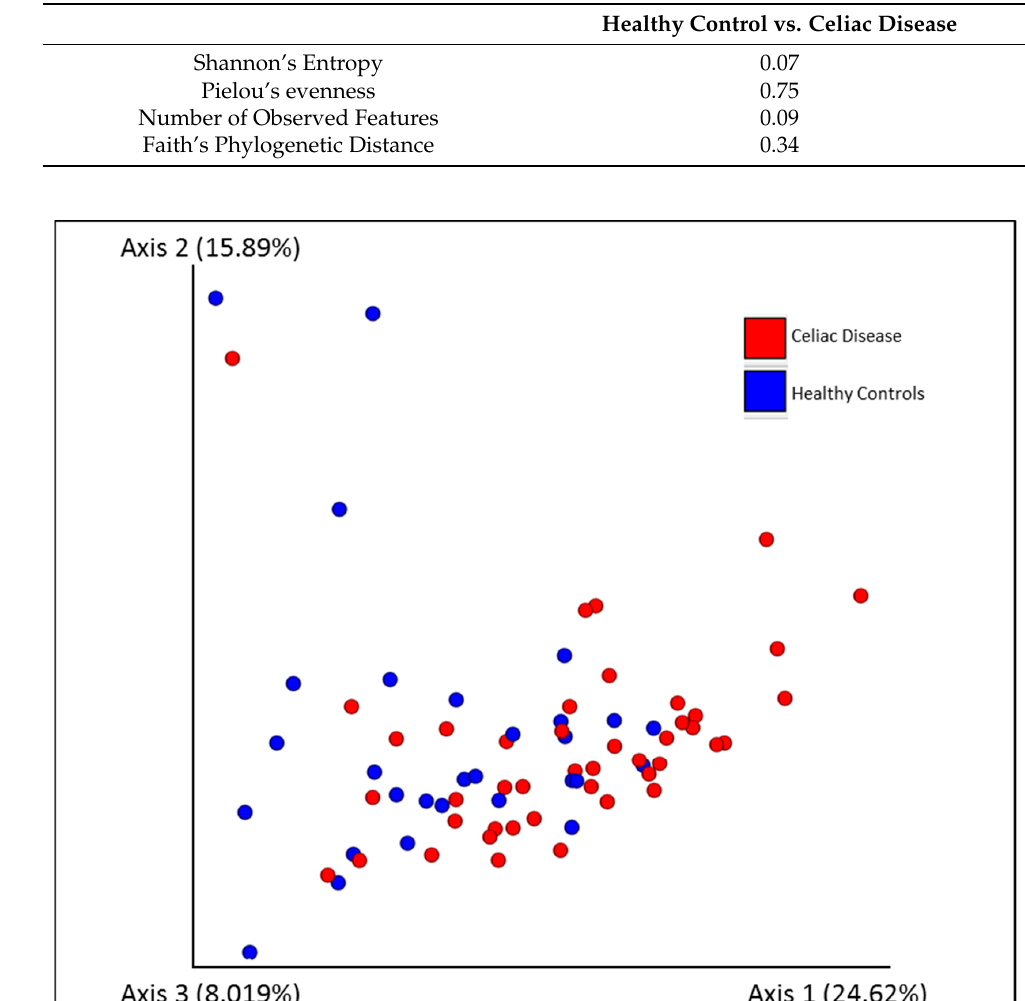
Table 2 . Summary of pairwise group comparisons for four alpha diversity indexes. Benjamini and Hochberg corrected p -values ( q -values) for Kruskal–Wallis tests are shown.